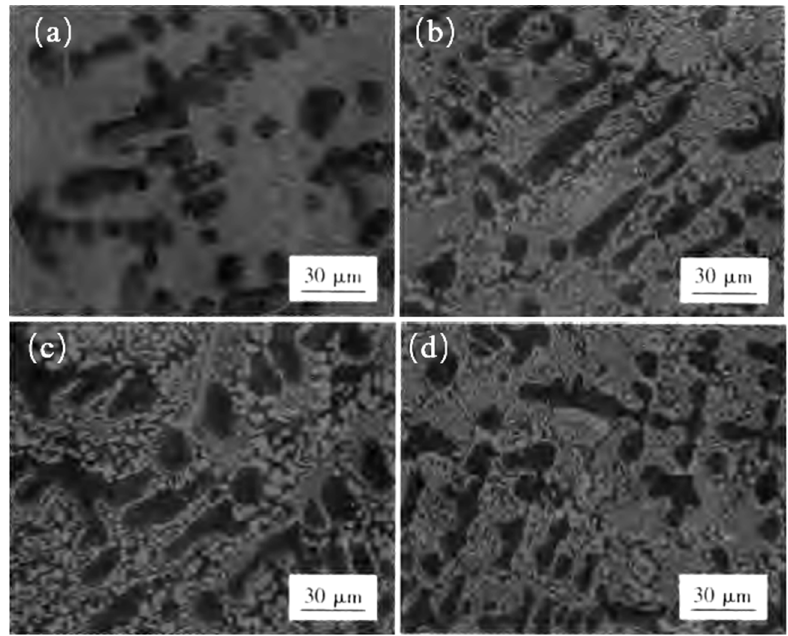
Figure 14. Microstructures of as-cast Cu-6.5P-xSn filler metals with different contents of Sn: ( a ) Sn 0%; ( b ) Sn 0.5%; ( c ) Sn 0.8%; ( d ) Sn 1% [52].